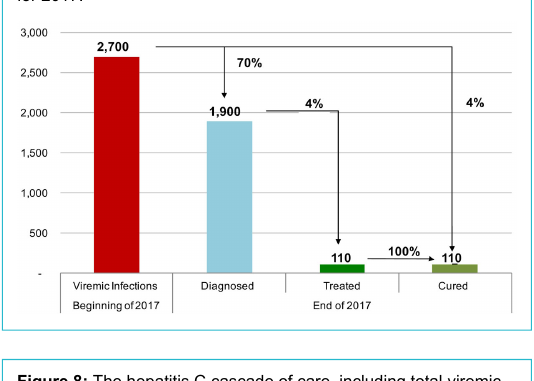
Figure 7: The hepatitis C cascade of care, including total viremic infections, diagnosed, treated and cured, in the canton of St Gallen for 2017.